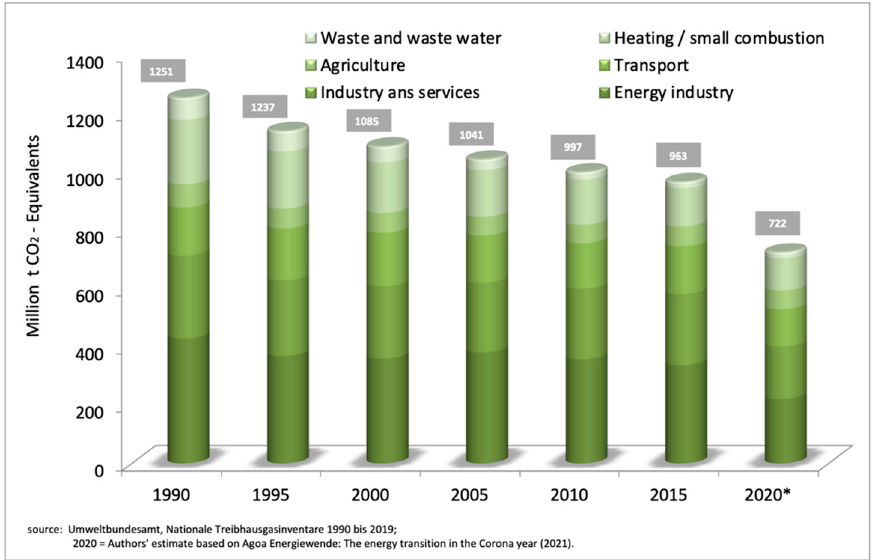
Figure 1. Development of greenhouse gas emissions by sector in Germany from 1990 to 2020 (Own presentation based on data from the German Federal Environment Agency 2020: https://www.umweltbundesamt.de/ (accessed on 9 June 2021) and Agora Energiewende 2021).